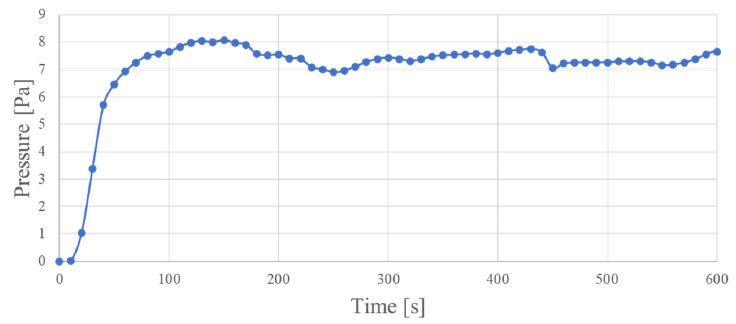
Figure 4. Paper actuator.